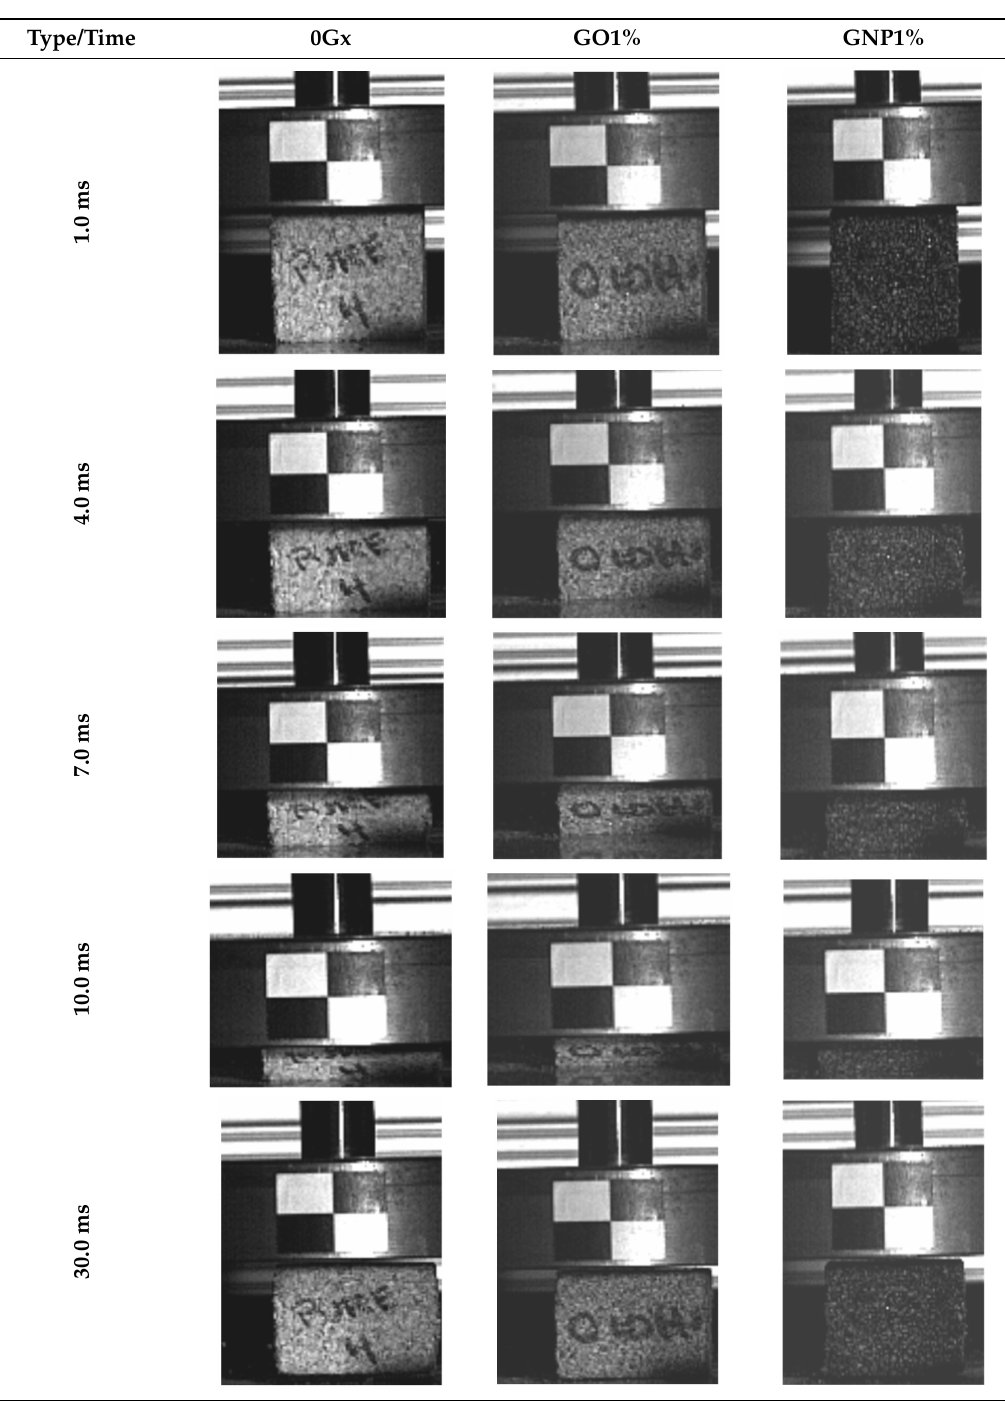
Table 2. Time sequence of the first impact for 3 different composite